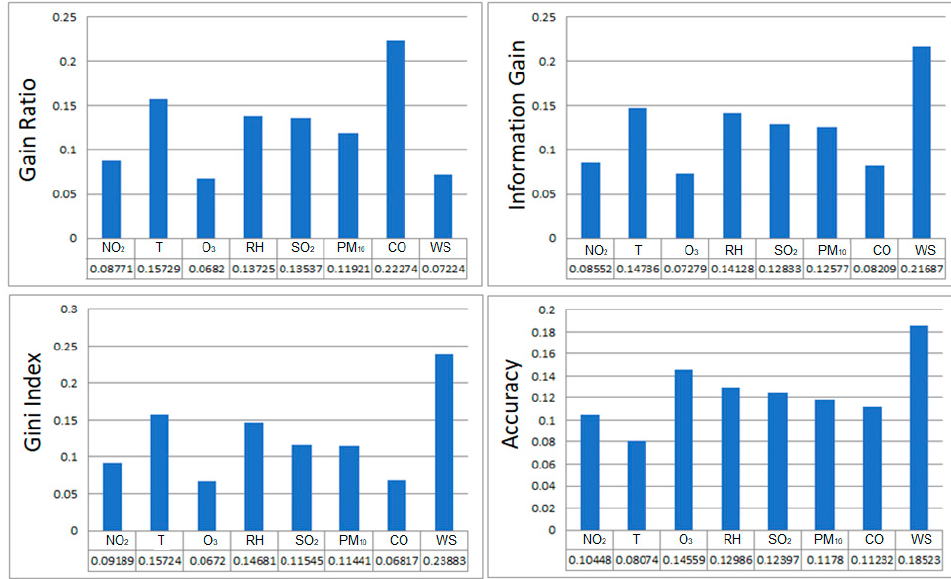
Figure 6. Feature importance for eight parameters (random forest (RF)